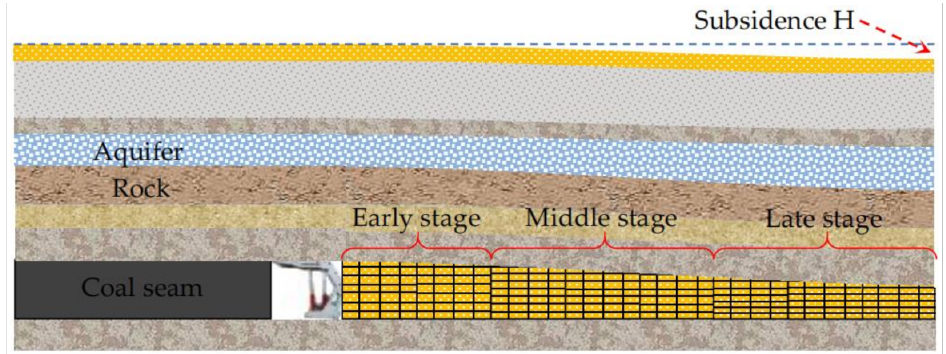
Figure 3. Sand-gabion backfill at different